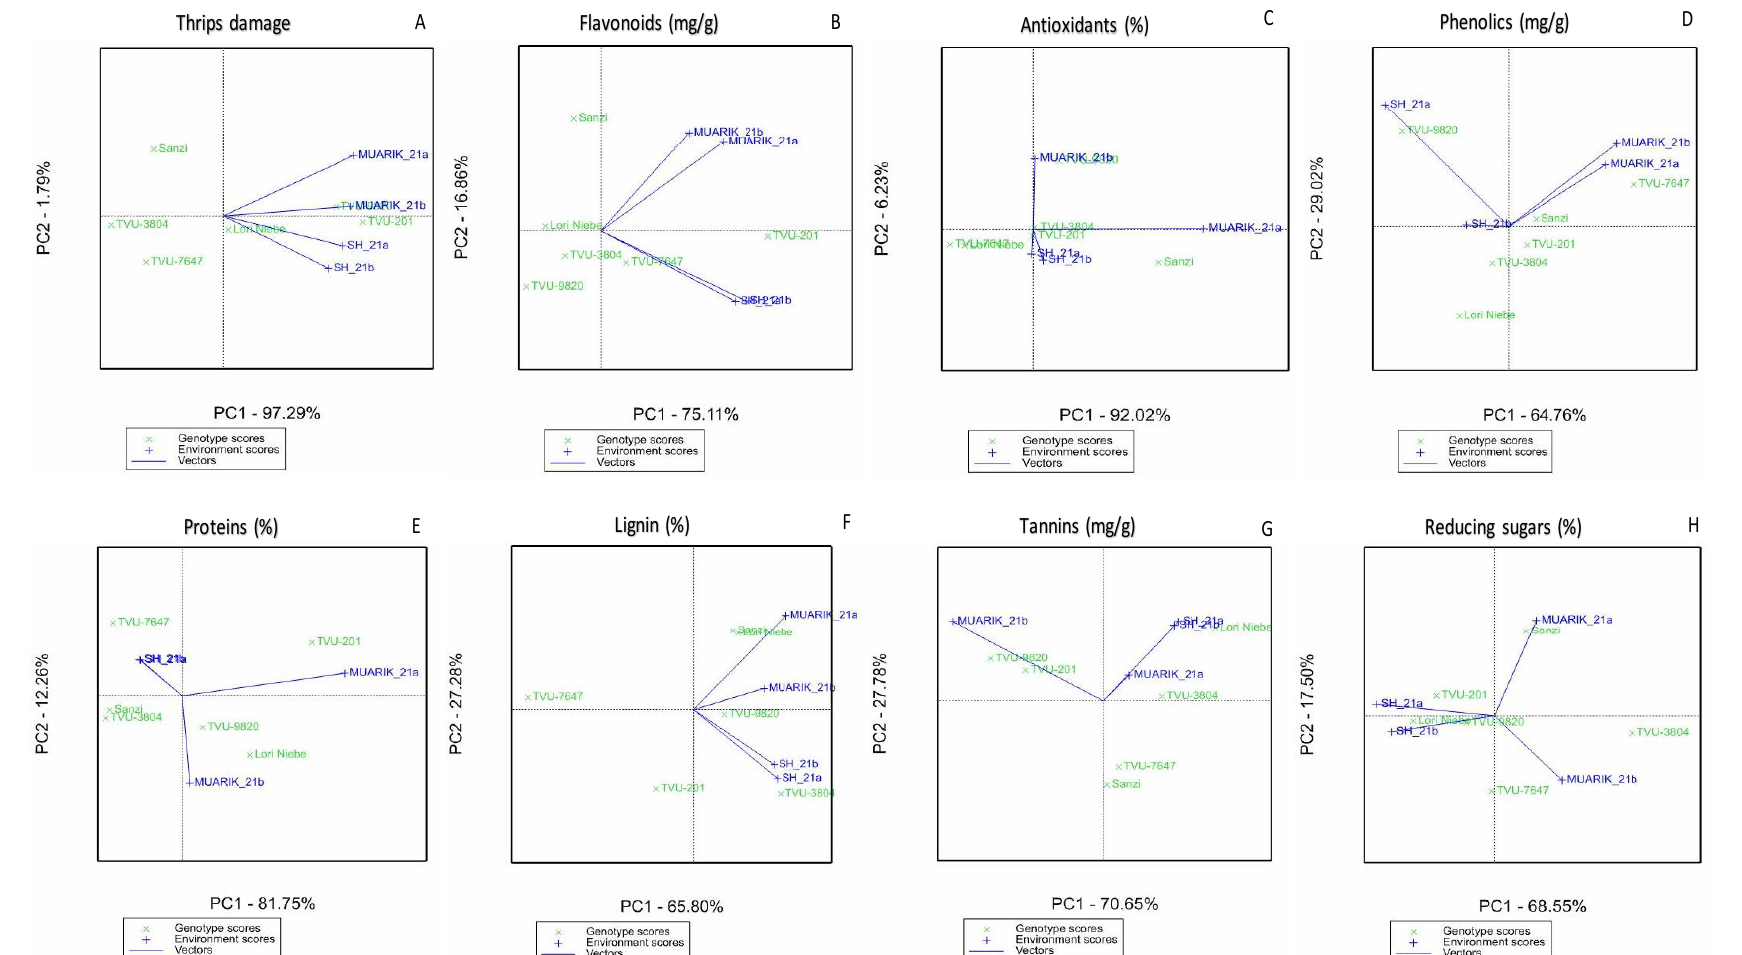
Figure 6. GGE biplot showing the relationship among the four environments in relation to flower thrips damage ( A ), flavonoids ( B ), antioxidants ( C ), phenolics ( D ), proteins ( E ), lignin ( F ), tannins ( G ) and reducing sugars ( H ) among six cowpea genotypes.